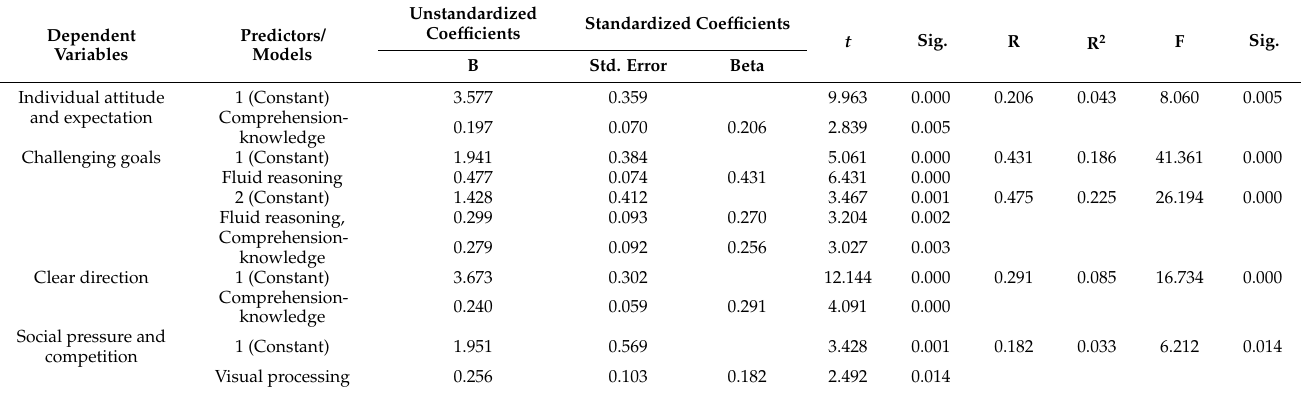
Table 9. Multiple linear regression models in group of participants of computer programming courses, the dependent variables are learning motivating factors, and the predictors are self-reported cognitive abilities. Dependent